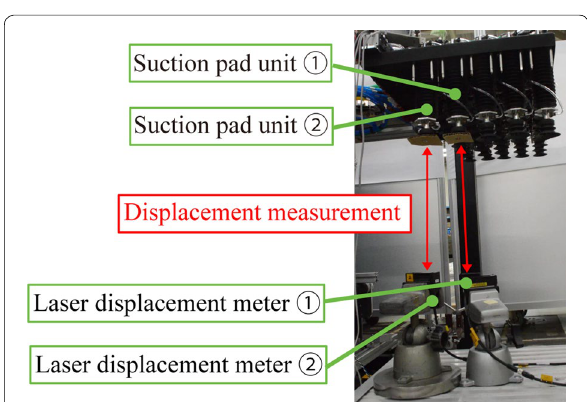
Fig. 25 Expansion and contraction motion evaluation experiment for the end